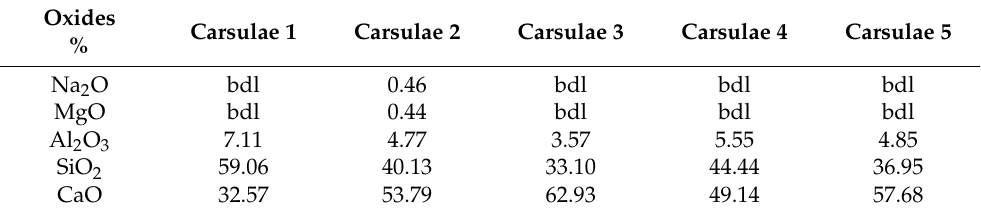
Figure 8. Microphotographs of binder of a waterproofing mortar of a Roman tank in Carsulæ (Terni, Italy, 1st century AD); ( a ) under PLM, xpl, and ( b ) SEM EDS layered map of Mg, Al, Ca, and Si (Mg: light blue; Al: orange; Ca: yellow; Si: pink). Table 6. Microchemical spot analyses of unmixed binder of a mortar coming a waterproofing mortar of a Roman tank in Carsulæ (Terni, Italy, 1st century AD).